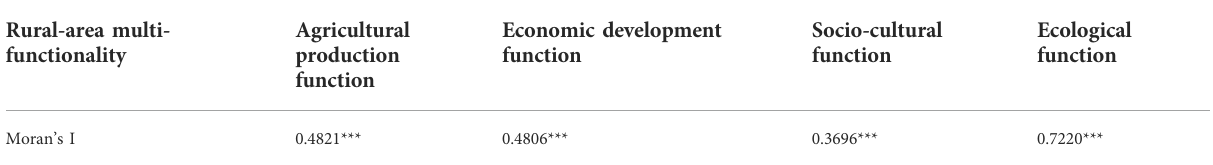
TABLE 3 Moran ’ s I value of rural -area multi-functionality in Hebei Province.